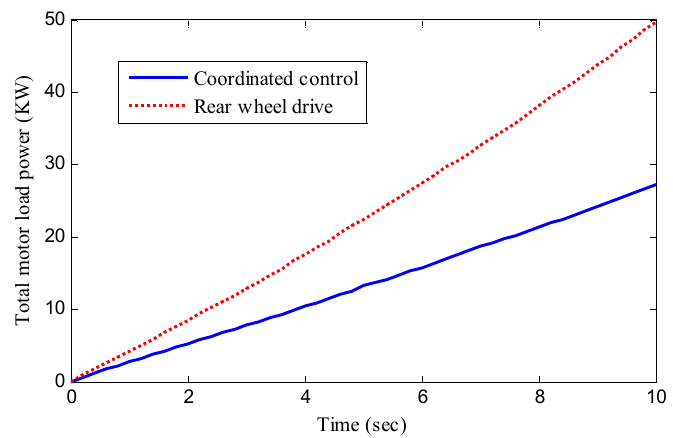
( a ) ( b ) Figure 18. Results of vehicle stability control in case study 2. ( a ) Yaw rate; ( b ) Sideslip angle. 5.3. ECE Manoeuver In order to verify the energy-saving effect of the proposed method under standard operating conditions, the simulation of an economic commission for Europe (ECE) manoeuver is carried out in case study 3. In the simulation of an ECE manoeuver, the steering control of vehicle is not implemented, and only the energy-saving effect under the standard working conditions is verified. The ECE urban cycle manoeuver for simulation is shown in Figure 19, and corresponding demand